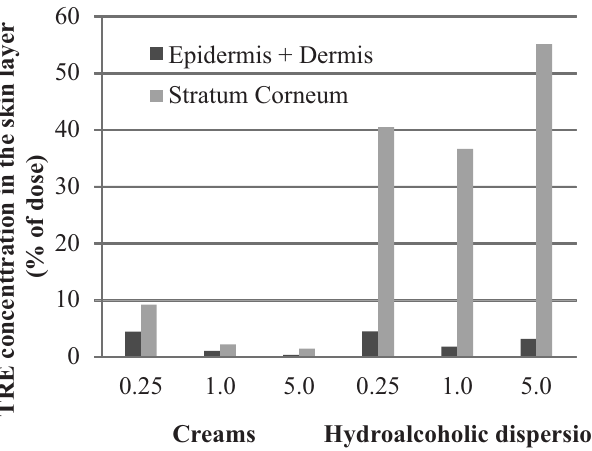
FIGURE 1 - Percentages of TRE in skin layers delivered from three concentrations of the drug in cream and hydroalcoholic dispersion